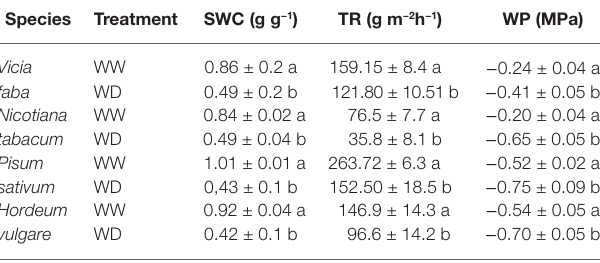
TABLE 1 | Mean soil water content (SWC), whole plant TR and the leaf WP of plants with full water supply (well-watered; WW) and plant exposed to gradual drying of substrate for several days (water-deficient;